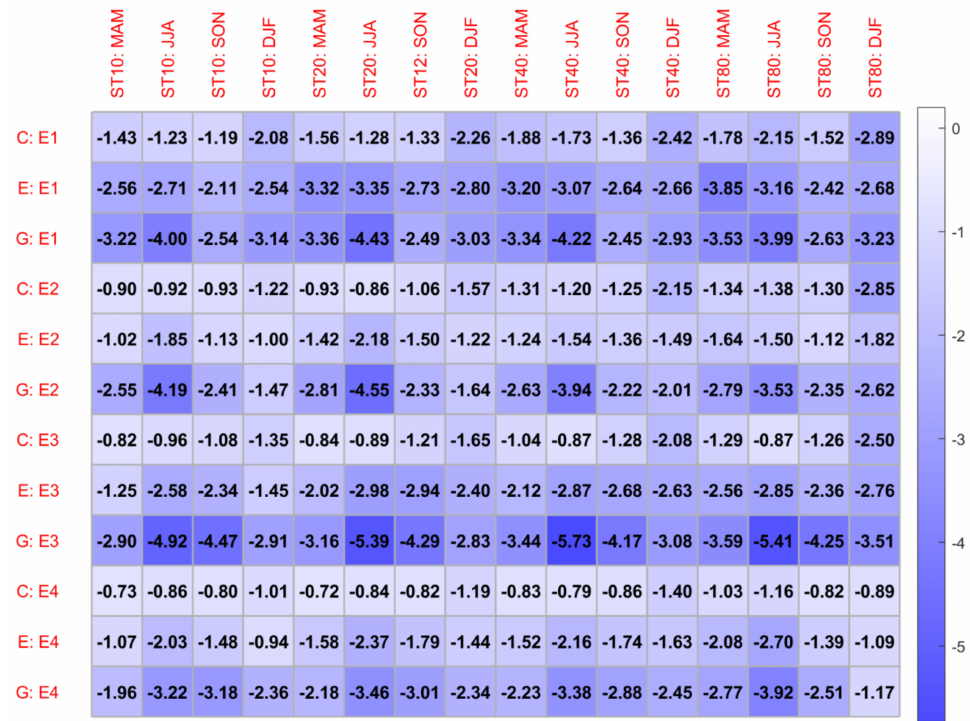
Figure 9. Seasonal variations in ME at different elevations. X label C is CLDAS, E is ERA-Interim, G is